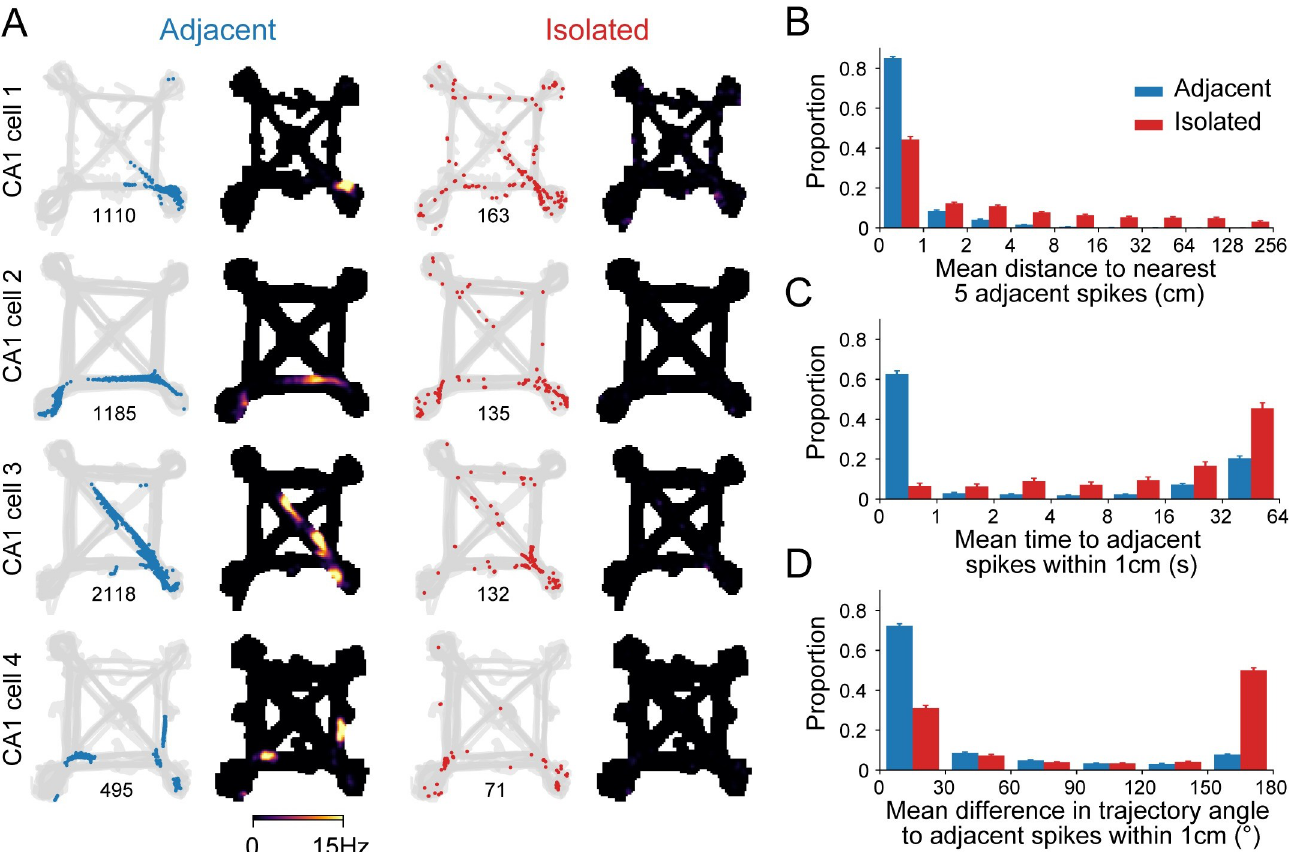
Fig 2. Spatial and temporal separation between isolated and adjacent spiking. (A) Location of spiking classified as adjacent or isolated activity for the 4 example cells in Fig 1A. Spike count shown below each panel. (B) Mean distance on the maze from one spike (adjacent: blue or isolated: red) to its nearest 5 neighboring adjacent spikes. The distance is the shortest path on the maze between 2 spikes. Wilcoxon rank sum test: p = 6.02 × 10 − 76 . (C) Mean separation in time between one spike and other adjacent spikes that occur at locations on the maze within 1 cm. Wilcoxon rank sum test: p = 3.10 × 10 − 57 . (D) Mean difference in the trajectory vector between one spike and other adjacent spikes within 1 cm. Wilcoxon rank sum test: p = 4.66 × 10 − 76 . (B–D) Histogram shows mean ± SEM for across 247 cells.